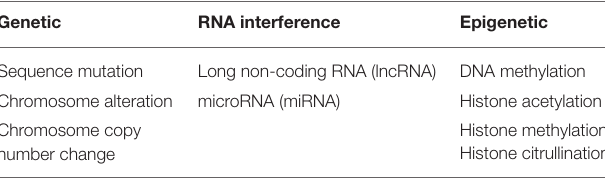
TABLE 1 | Genetic, regulatory, and epigenetic